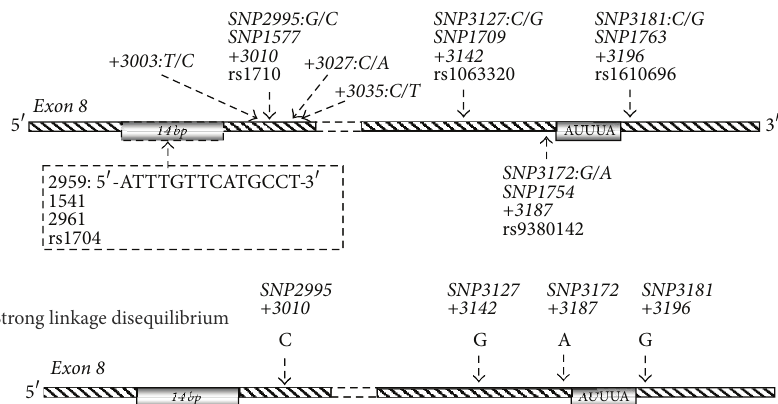
Figure 1: Polymorphisms in the 3 󸀠 -untranslated region (3 󸀠 UTR) of the HLA-G gene. The 3 󸀠 UTR haplotype shown below has been associated with the risk of developing severe preeclampsia [25]. (Nomenclature used by different authors is shown for clarification. “ SNPxxxx ,” for example, SNP3127 , is based on the original publication of the HLA-G gene sequence by Geraghty et al. [26] and the study of HLA-G 3 󸀠 UTR haplotypes in cases of severe preeclampsia by Larsen et al. [25]; “ +xxxx ,” for example, +3142 , by the publication by Castelli et al. [27]. (Based on [25, 27,